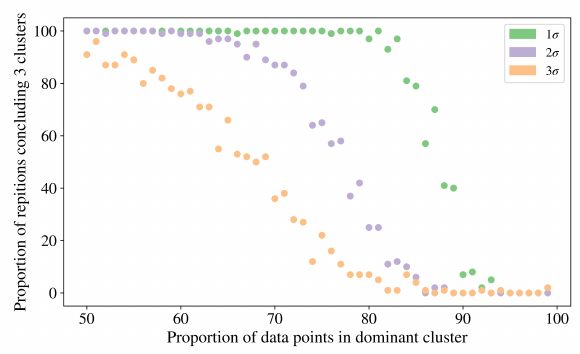
Figure 10. Percentage of simulations for which the CH index at- tained a maximum for the clustering containing 3 clusters against the proportion of the data which is placed into a dominant